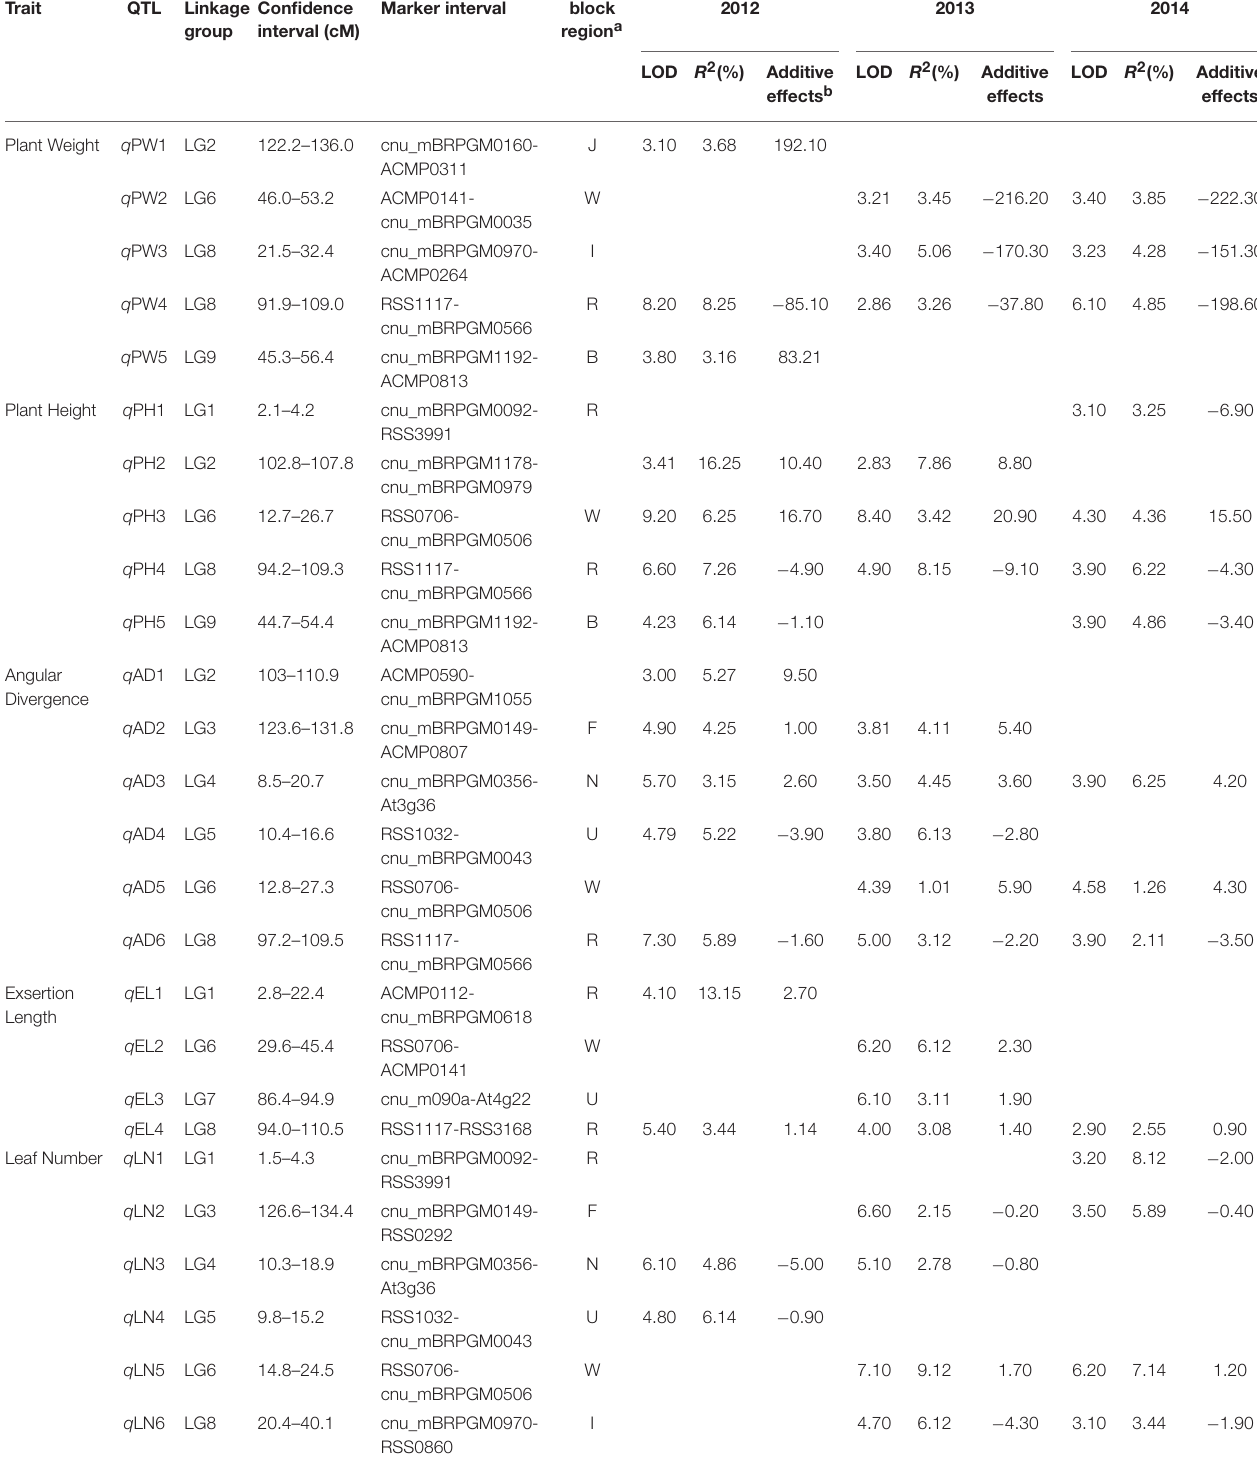
TABLE 2 | Position and effect of QTL for 11 morphological traits in R. sativus.